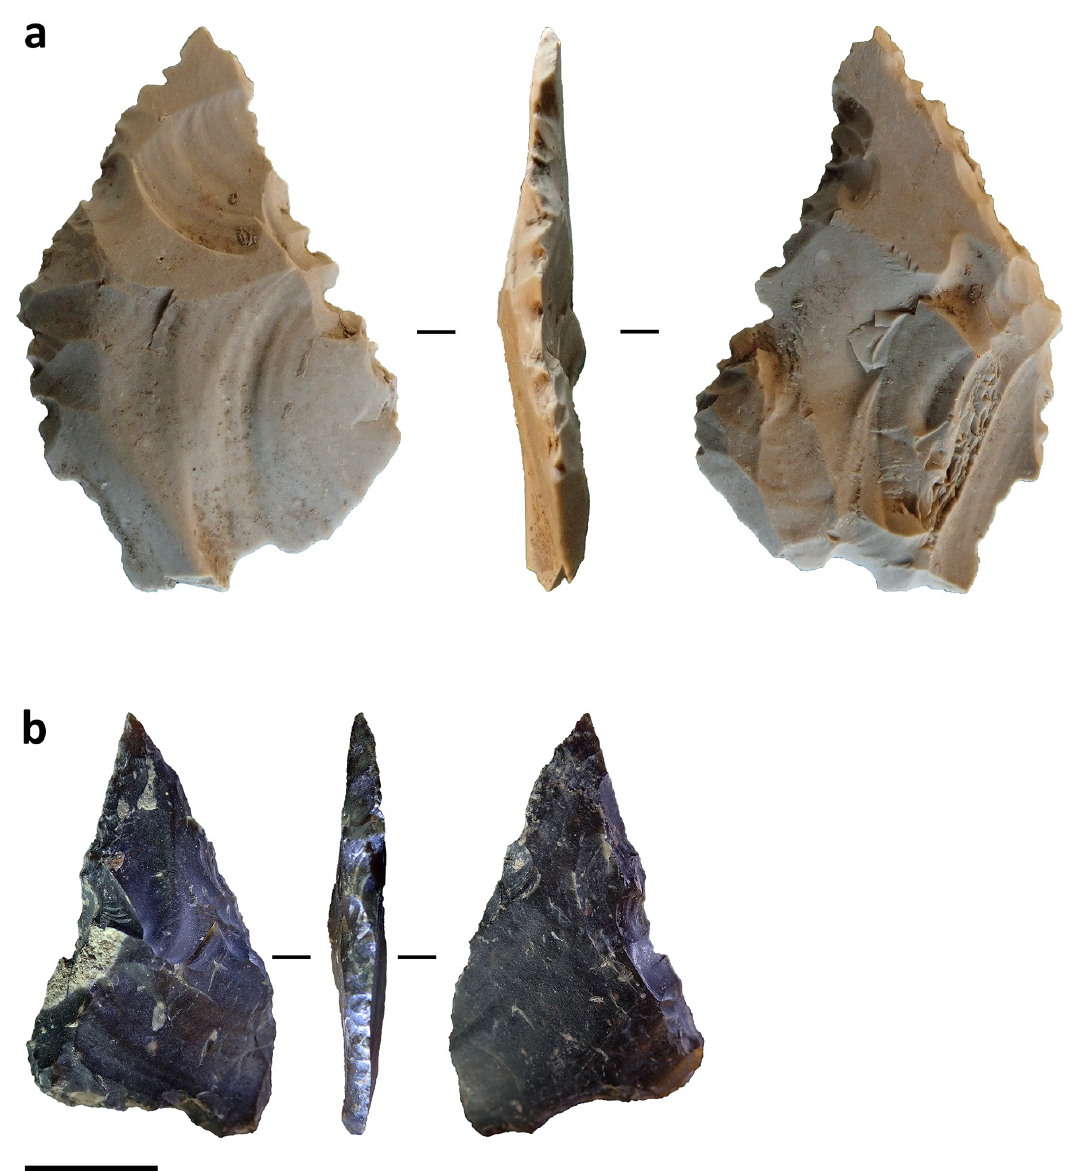
Fig 15. Lompoa points made on a bipolar flakes. (a) Artefact recovered from Leang Pajae, Test Pit 2, 0–10 cm below the surface. (b) Artefact from Leang Rakkoe, Test Pit 1, 1–10 cm below the surface [32]. The pressure retouching scars intrude into the scars created in bipolar reduction. Scale bar = 1